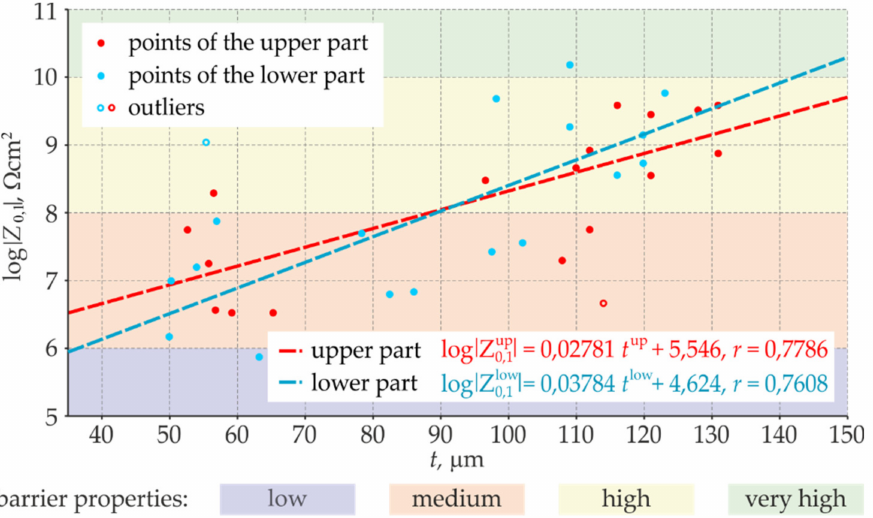
Figure 15. Correlation relationships between the thickness t of the blue coating and the logarithm of impedance modulus Z 0.1 were determined separately for the upper and lower parts of the sheet (in red and blue, respectively, for points, lines and empirical equations).